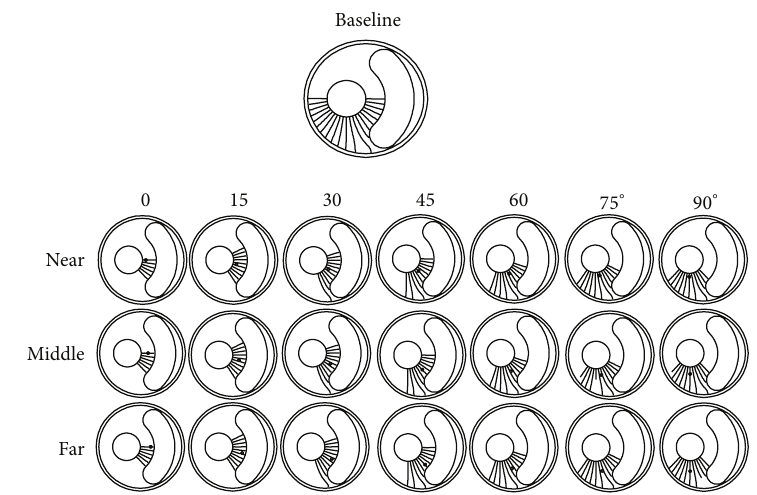
Figure 2: Rupture paths for all cases.